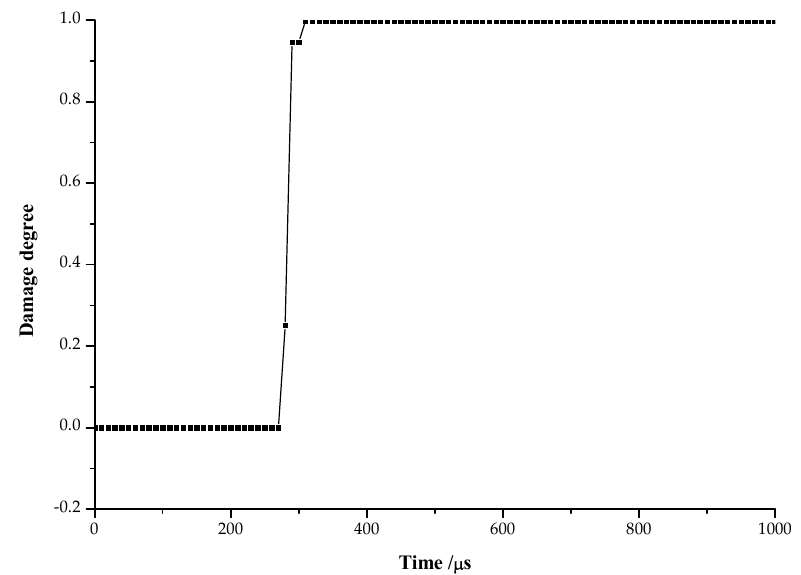
Figure 9. Damage degree–time curves for monitoring point 1.